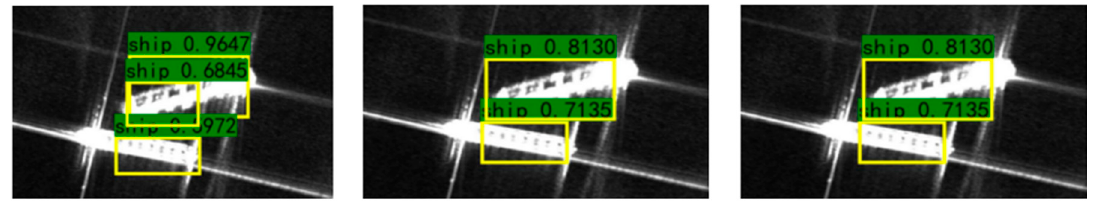
Figure 11. Comparison of IoU -NMS, DIoU -NMS, and CIoU -NMS.